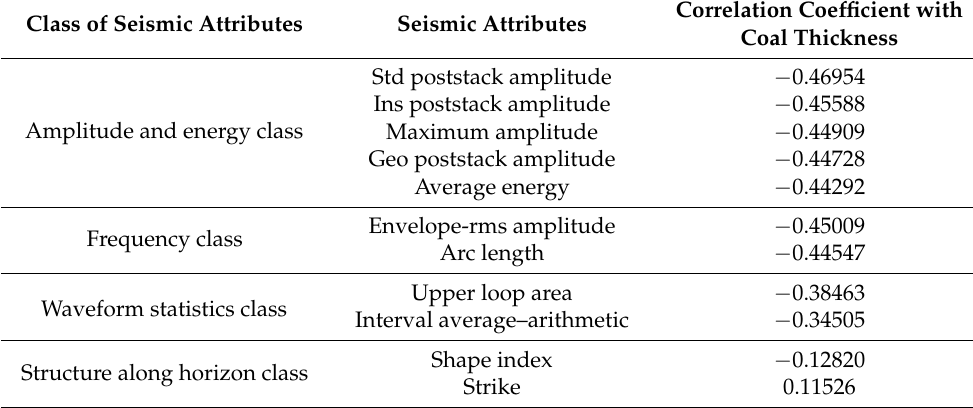
Table 2. Seismic attribute correlation analysis in the development